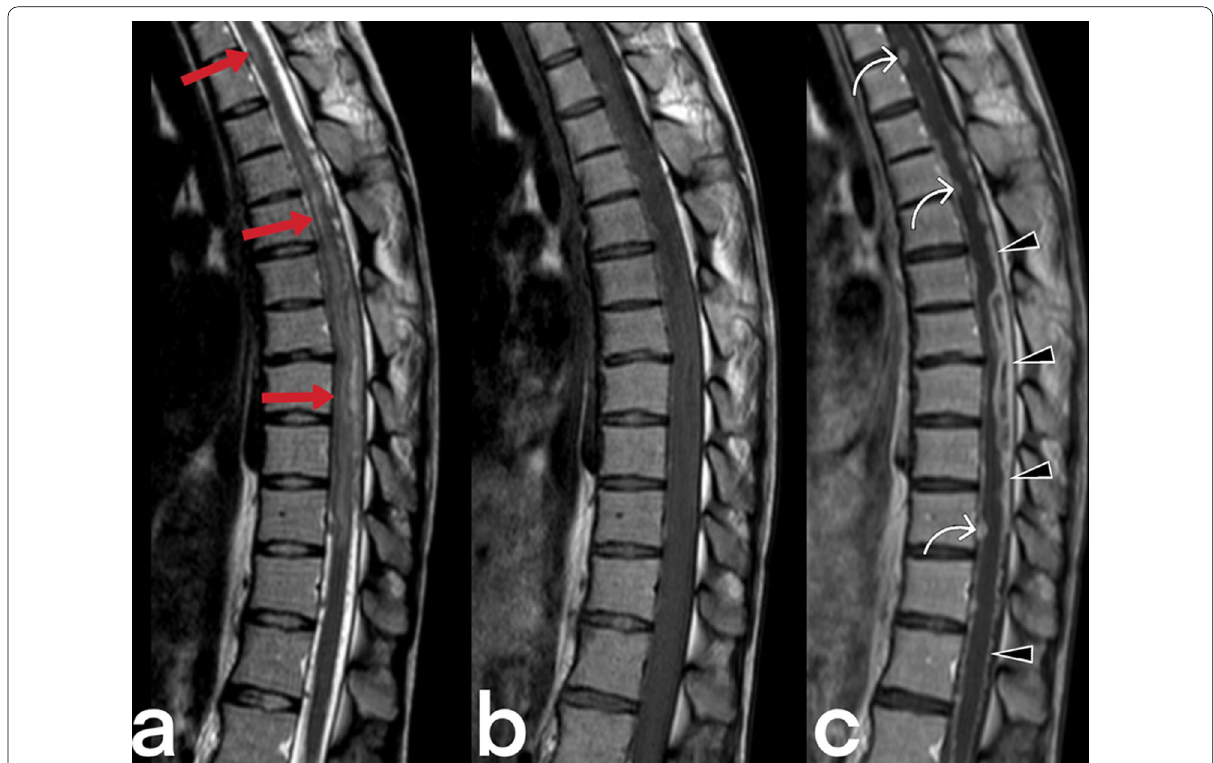
Fig. 5 MR images of thoracic vertebrae of a 23-year-old female. Sagittal T2-weighted image reveals a heterogeneous signal increase in the spinal cord (red arrows) ( a ). Precontrast ( b ) and postcontrast ( c ) T1 weighted images of the same patient show linear (arrowheads) and nodular (curved arrow) dural enhancement and tuberculous abscess formations in the posterior epidural